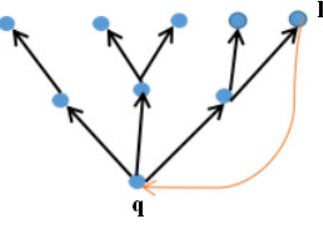
Figure 2. A unicyclic graph Q